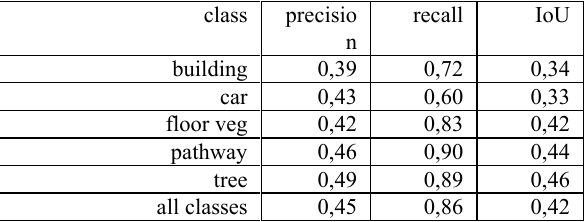
Table 3. Results investigation using point clouds